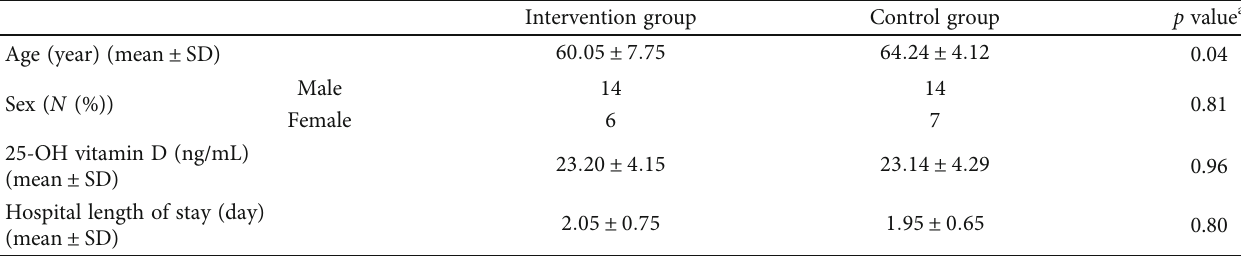
Figure 1: Consort chart of the study. Table 1: Baseline data of two groups of the